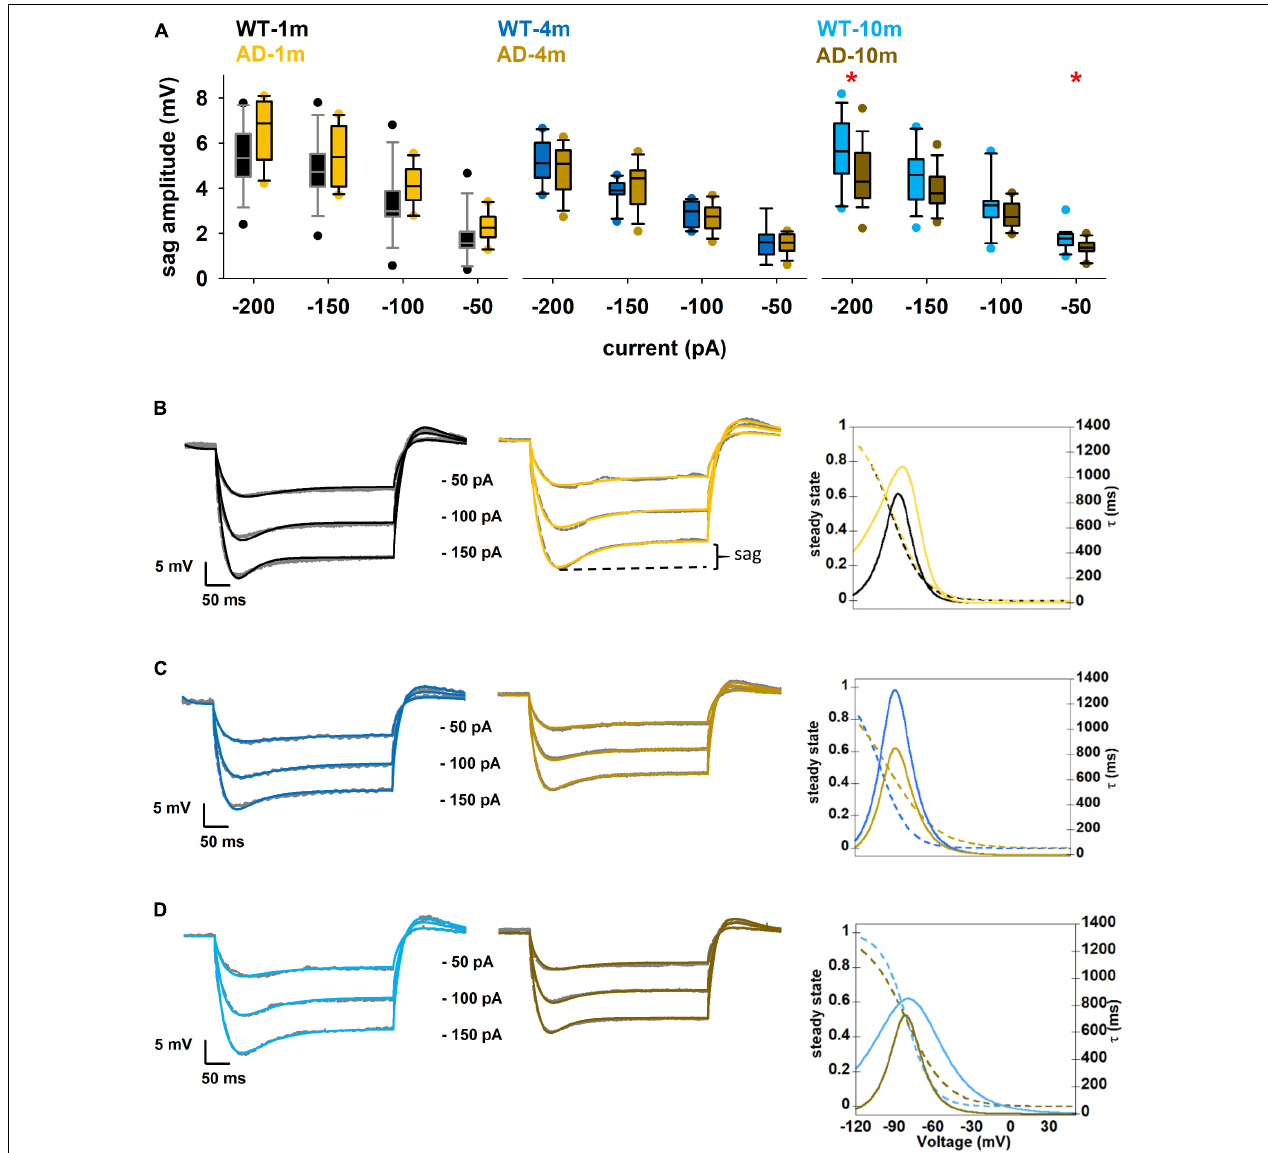
FIGURE 3 | Differences in I h current properties. (A) Box plot of sag amplitude as a function of current injection; See full statistical analysis for sag amplitude in Supplementary Table 2 . (B–D) Comparison between model (colored) and experimental (gray) traces under Control and AD conditions for 1, 3–4, and 9–10 months, panels (B–D) , respectively; ( left and middle ) best fit of experimental traces for each condition; ( right ) kinetic curve for each genotype. Dotted lines represent steady state and solid lines represent time constant of activation of I h current. * p ≤